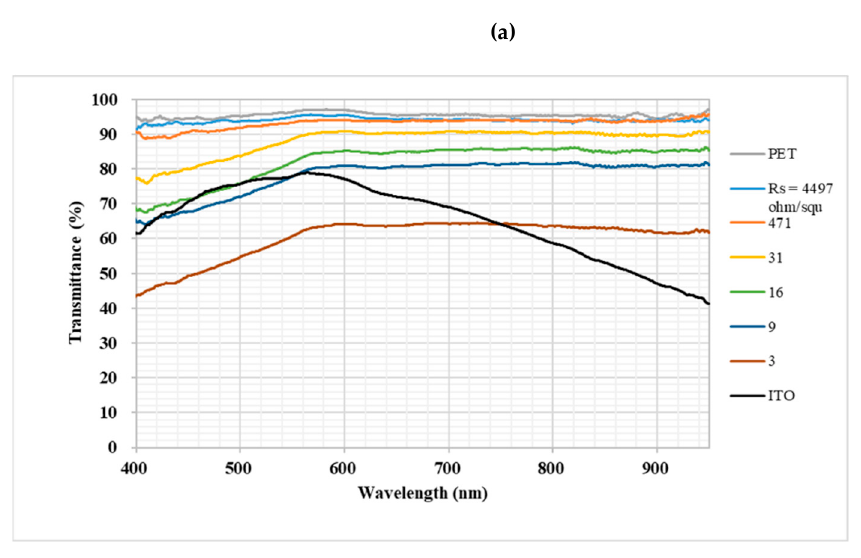
Figure 2. ( a ) Sheet resistance and transmittance (at 550 nm) as a function of the surface mass den- sity of as-prepared AgNWs films; ( b ) Comparison of transmission curves of PET films, as-pre- pared AgNWs with different sheet resistance on PET and ITO on PET